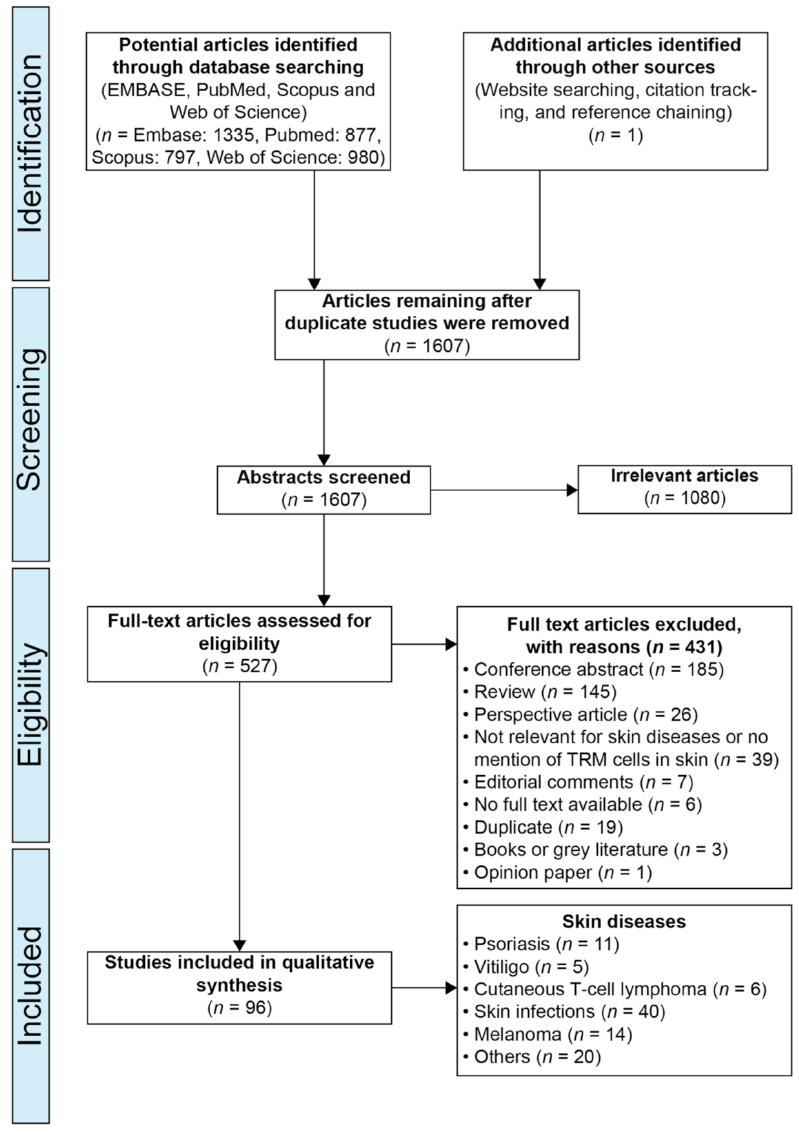
Figure 1. Literature search strategy. A total of 1335 records were found in Embase, 877 in Pubmed, 797 in Scopus and 980 in Web of Science. In total 1607 records were found. Abstracts were screened for eligibility using inclusion and exclusion criteria (see Material and Methods). The full texts of studies included at this stage were then reviewed, and 431 of the reviewed texts were excluded for being a conference abstract (185), a review (145), a perspective article (26), irrelevant for skin diseases or failing to mention TRMs in the skin (39), an editorial comment (7), having no full text available (6), a duplicate (19), books or grey literature (3) and an opinion paper (1). In total, 95 publications from the literature search were included. One additional article was included after screening the references of studies from the search result; and following external review, this produced to a total of 96 articles. TRMs = Tissue-Resident Memory T